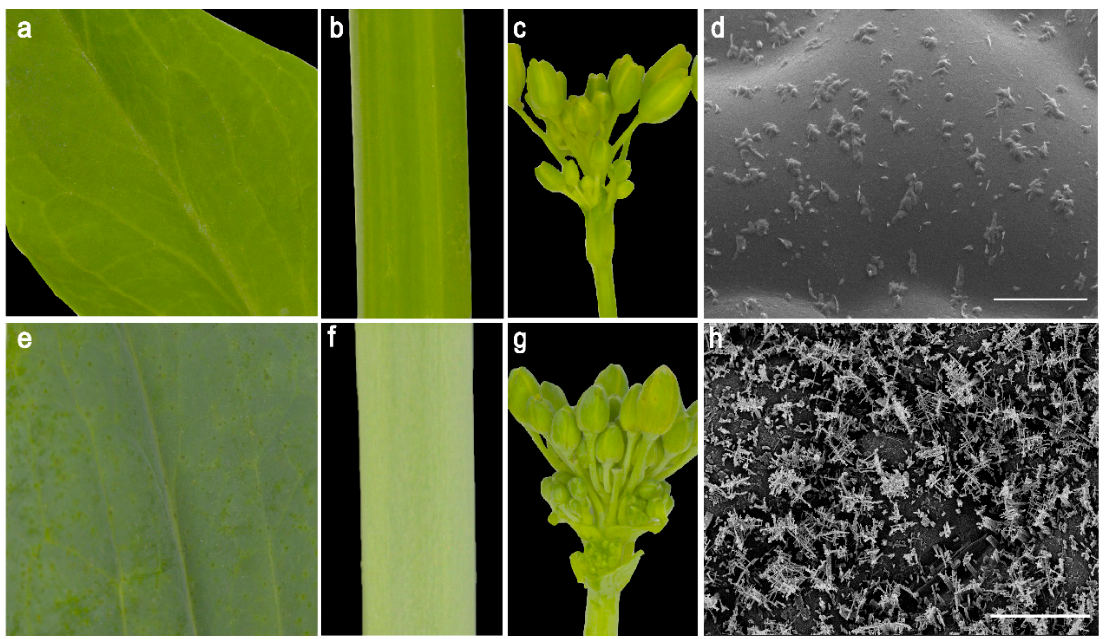
Figure 1. Phenotypic characterization of cuticular waxes in the two parent lines (SD369 and R16-11). The stem ( a ), leaf ( b ), and flower buds ( c ) of SD369 showed glossy phenotype at the bolting stage, as compared to the waxy appearance of R16-11 stem ( e ), leaf ( f ), and flower buds ( g ). Cryo-scanning electron microscopy images of leaves from SD369 ( d ) and R16-11 ( h ). Bar = 10 µ m in ( d , h ). Table 1. Genetic analysis of the glossy trait in crosses between SD369 and R16-11. Population